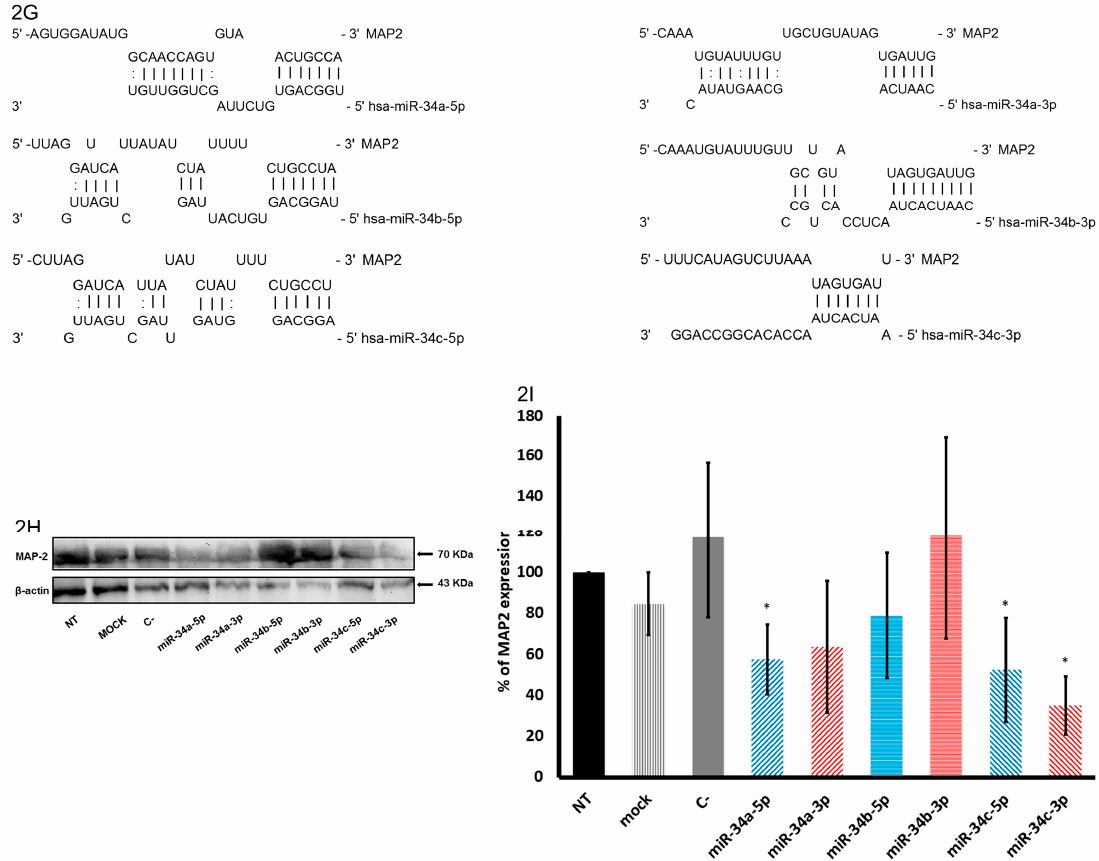
Figure 2. Ectopic expression of miR-34 family members affects cell migration and invasion in SiHa cells. ( A ) SiHa cells were transfected with 5 nM pre-miR-34a-5p, pre-miR-34a-3p, pre-miR-34b-5p, pre-miR-34b3p, pre-miR-34c-5p, and pre-miR-34c-3p mimics, or scrambled pre-miRNA control (C-) mimic. The cells were treated with mitomycin C (1.2 µ g/ml) and 8 × 10 4 cells were seeded in transwell inserts to analyze migration 72 hours post-transfection. ( B ) The inserts were recovered with matrigel and 8 × 10 4 cells were seeded, previously transfected with 5 nM pre-miR-34a-5p, miR-34a-3p, miR-34b-5p, miR-34b3p, miR-34c-5p, and miR-34c-3p mimics, or scrambled pre-miRNA control (C-) mimic and treated with mitomycin C (1.2 µ g/ml) to analyze invasion 72 hours post-transfection. The photograph on the top corresponds to one representative experiment of the assays. ( C ) Schematic representation of miR-34 family members binding sites in the 3’ untranslated region (UTR) of matrix metalloproteinases 2 and 9 (MMP2 and MMP9) with databases miRWalk, Target Scan, and RNA22-HSA. ( D ) Supernatant was collected from cells transfected with 10 nM pre-miR-34a-5p, miR-34a-3p, miR-34b-5p, miR-34b3p, miR-34c-5p, and miR-34c-3p mimic, or scrambled pre-miRNA control (C-) mimic, and MMP2 and 9 activity was analyzed 72 hours post-transfection. ( E ) Graphs showing the quantification of the effect of 5p and 3p strands of miR-34 family members on MMP2 activity from three independent experiments ( p < 0.05). ( F ) Graphs showing the quantification of the effect of 5p and 3p strands of miR-34 family members on MMP9 activity from three independent experiments ( p < 0.05). ( G ) Schematic representation of miR-34 family members binding sites in the 3’ UTR of microtubule-associated protein 2 (MAP2) with databases miRWalk, Target Scan, and microRNA.org. ( H ) Protein extraction was obtained from cells transfected with 10 nM pre-miR-34a-5p, miR-34a-3p, miR-34b-5p, miR-34b3p, miR-34c-5p, and miR-34c-3p mimics, or scrambled pre-miRNA control (C-) mimic, and MMP2 activity was analyzed using Western blot. ( I ) Graph showing the quantification of the effect of 5p and 3p strands of miR-34 family members on MAP2 protein from three independent experiments in triplicate ( p < 0.05). The bars represent the means and standard deviations of three independent experiments ( p <